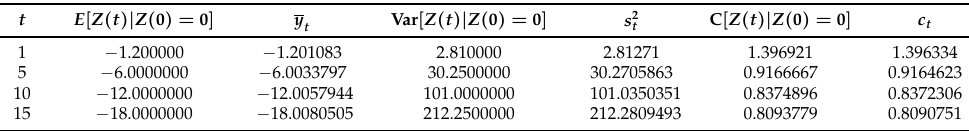
Table 1. The conditional mean, variance, and coefficient of variation of Z ( t ) are compared with the estimated values y , s 2 and c t obtained by means of Algorithm 1 with the same choices of the t t parameters of Figure